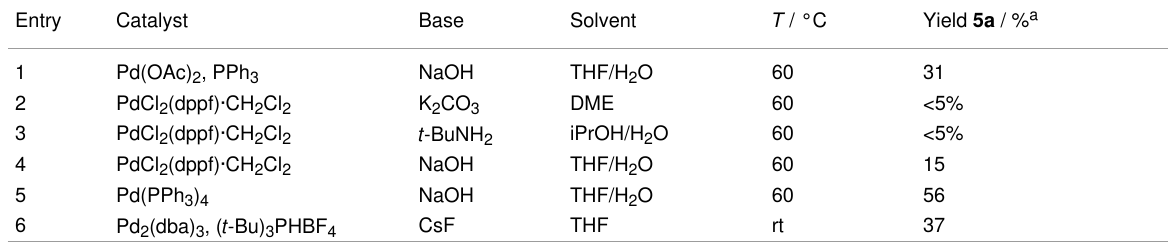
Table 1: Pd-catalyzed Suzuki–Miyaura coupling reaction of norbornadiene 2a and bromobenzene ( 4a ) at different reaction conditions. Entry